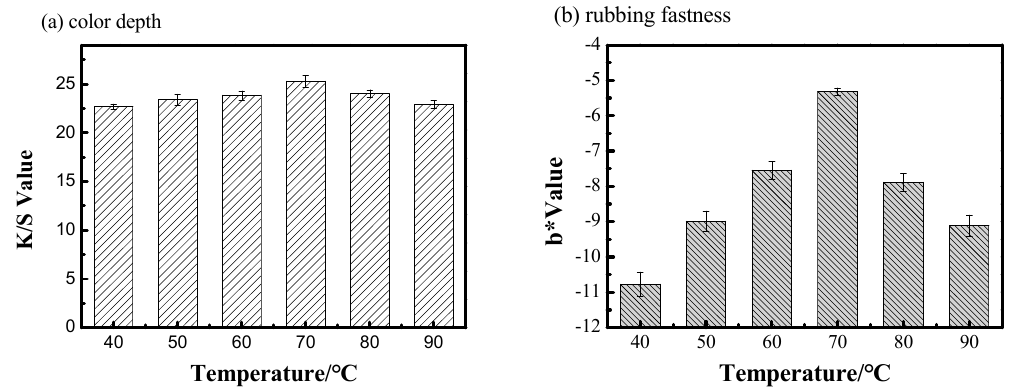
Figure 3. Effect of temperature on the color depth ( a ) and rubbing fastness of dyed cotton fiber ( b ).